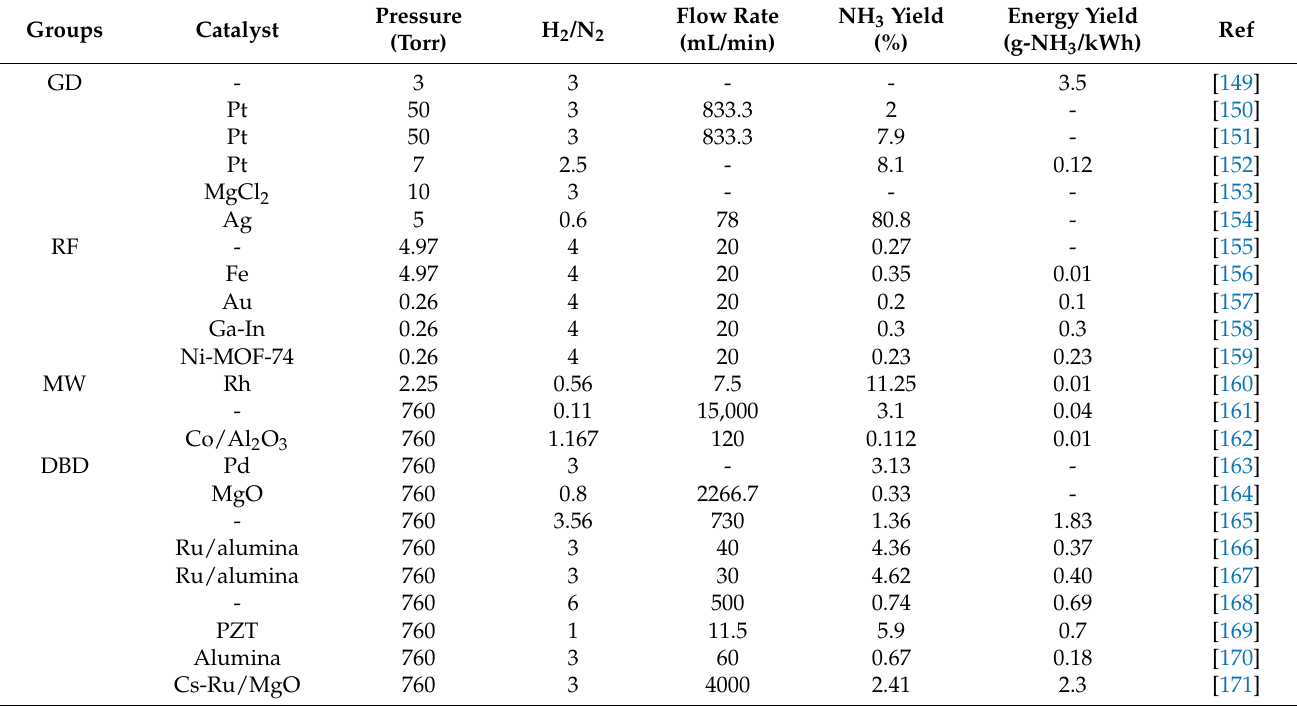
Table 9. Summary of previous research on plasma-chemical for ammonia synthesis.